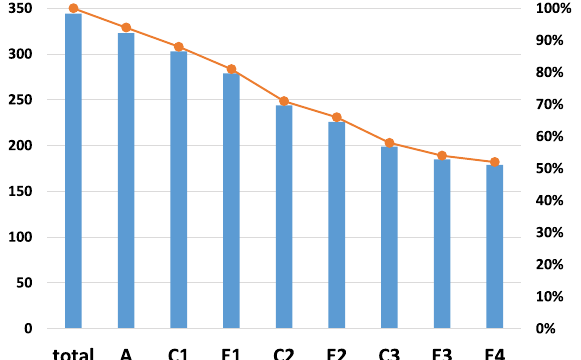
FIG. 3. The correctness of each step as students progressed through the energy eigenvalue problem. In the graph, the histogram denotes the number of correct solutions, and the dots label the correct percentage with respect to the total